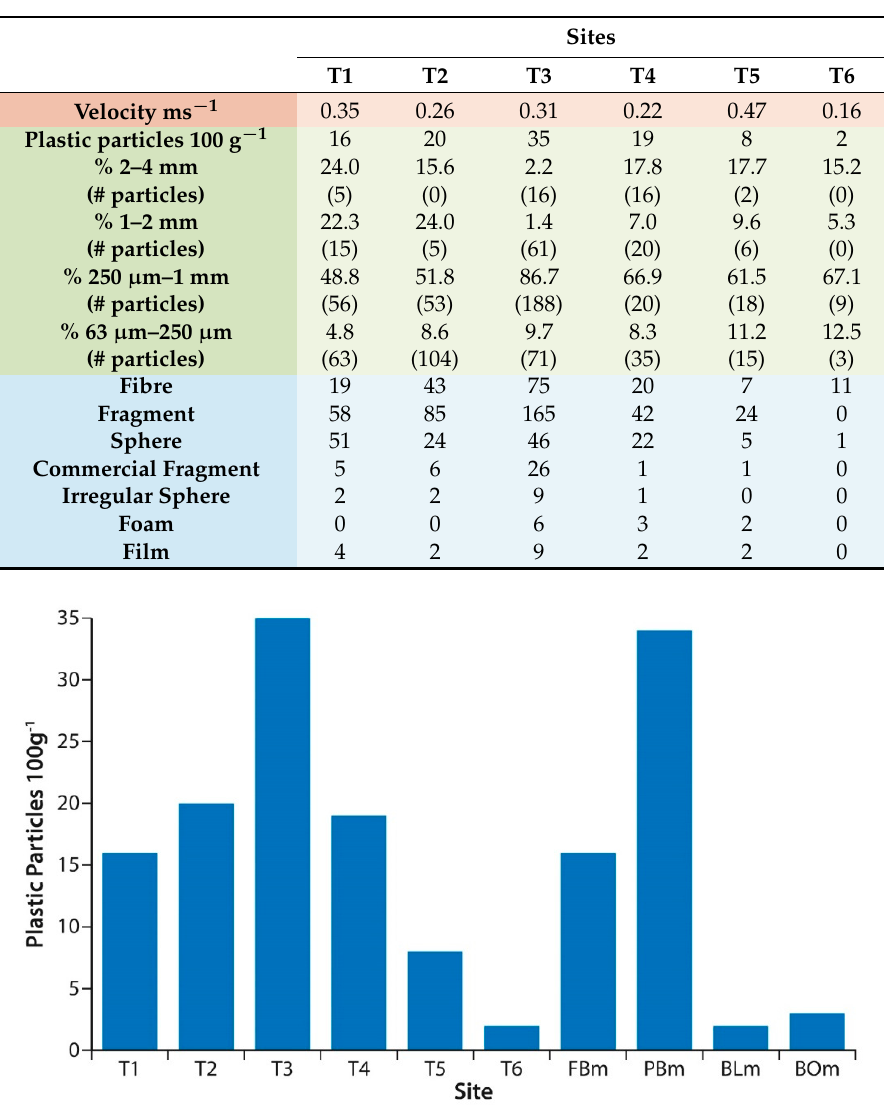
Figure 2. Plastic particle abundance at each site, see Figure 1 for locations.